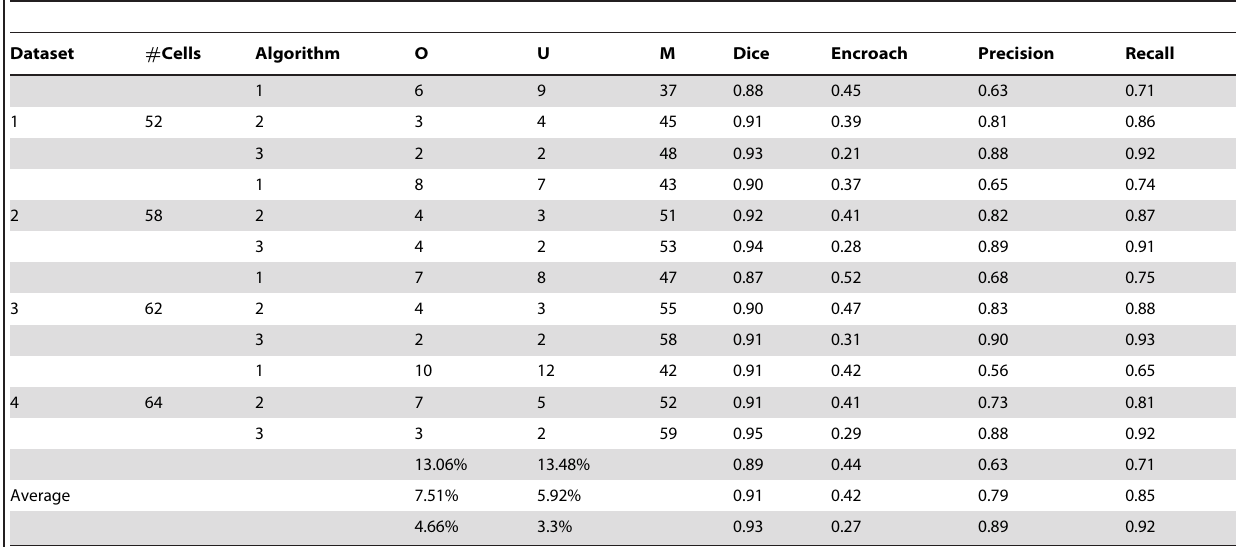
Table 3. Robust correspondence of automated segmentations with manually segmented zebrafish membrane images.